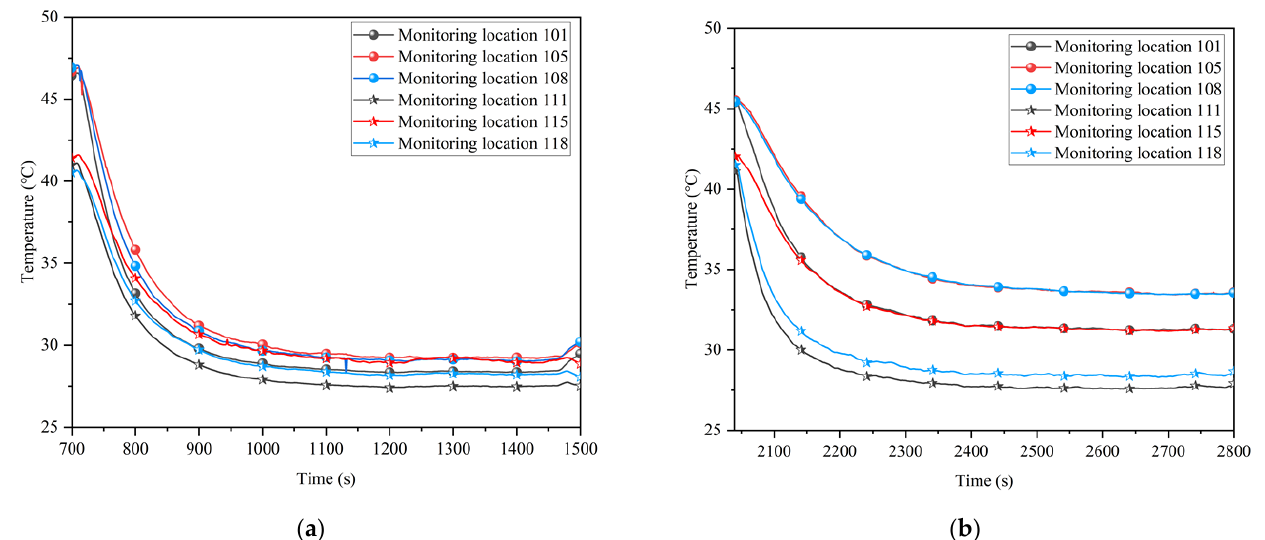
Figure 8. Comparison of cooling limits at upper and lower monitoring locations with and without insulation: ( a ) With insulation; ( b ) Without